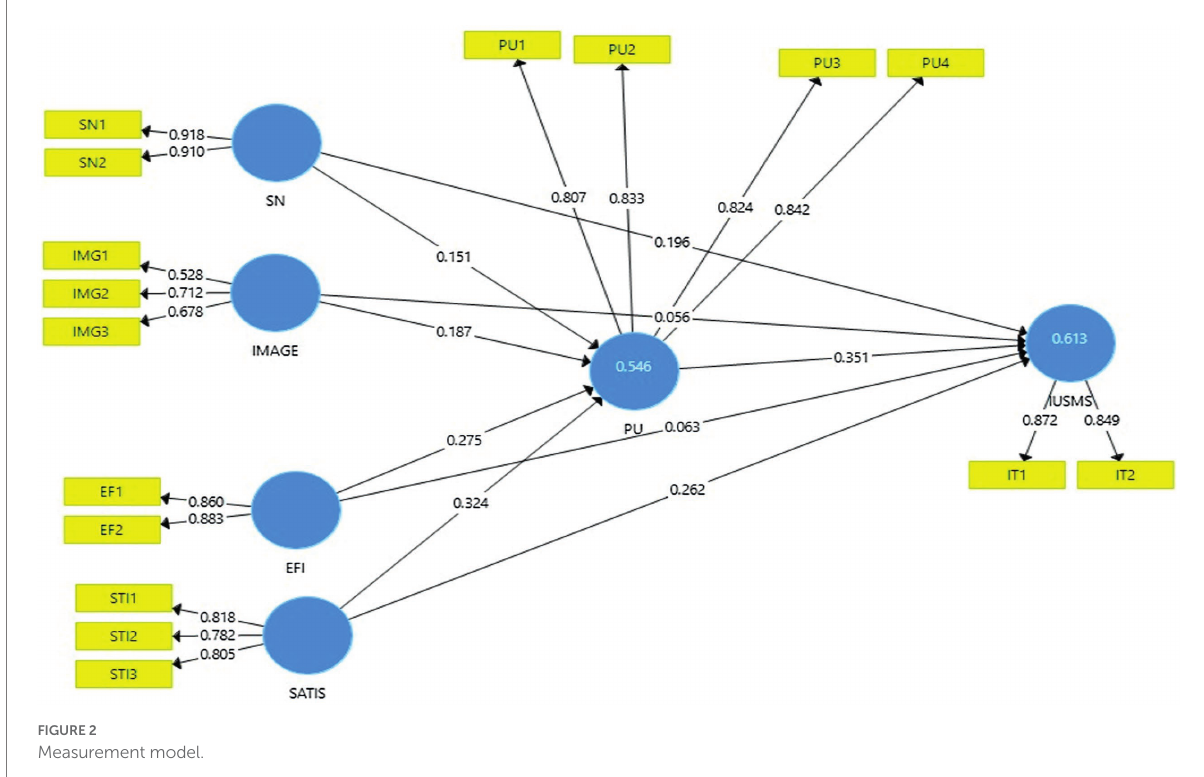
FIGURE 2 Measurement model.